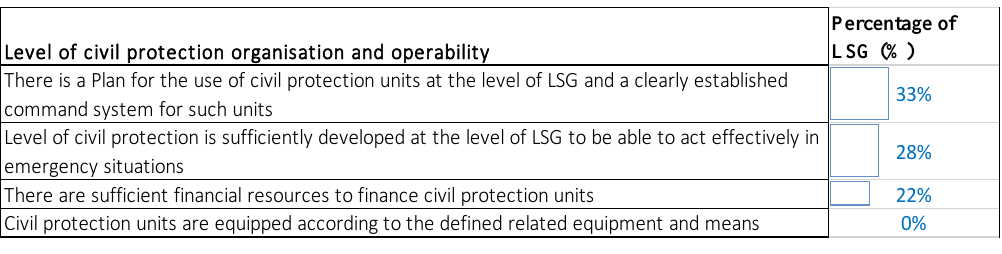
Table 3: Level of Civil Protection Organization and Operability (Source: Authors’ research)